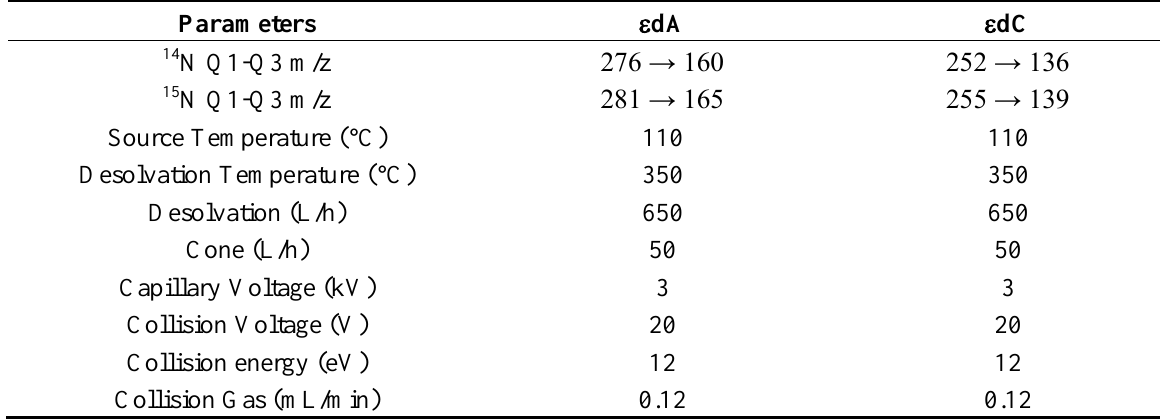
Table 1. ACQUITY TQD mass spectrometry for the detection of etheno-DNA adducts in human urine by